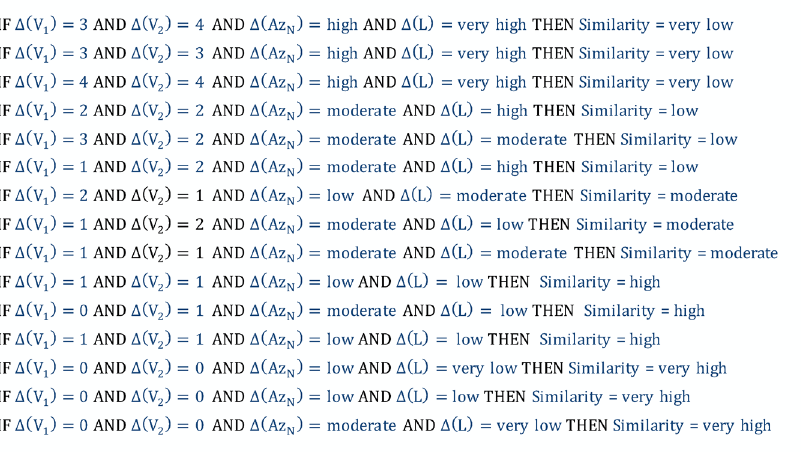
Fig. 14. a section of the rules from experts’